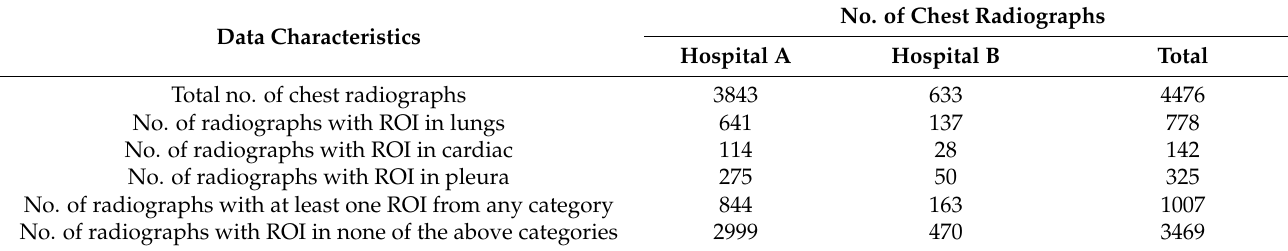
Table 2. Category-wise distribution of chest radiographs in the external test datasets. Data Characteristics